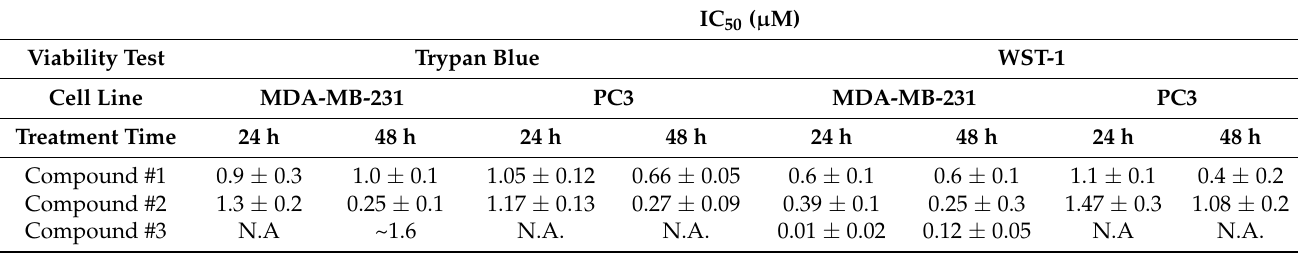
Table 5. IC50 values calculated either via Trypan Blue or WST-1 tests 24 and 48 h post-treatment